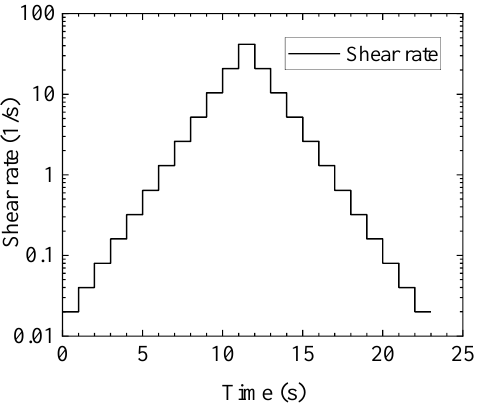
Figure A4. Shear rate and time relation in the hysteresis loop experiment.